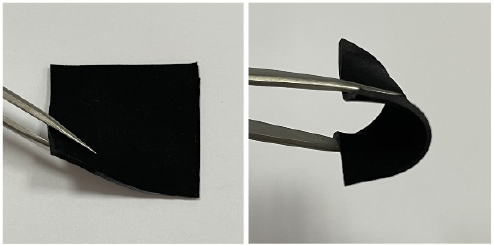
Figure 9. Optical photographs of the CF–rubber composites.